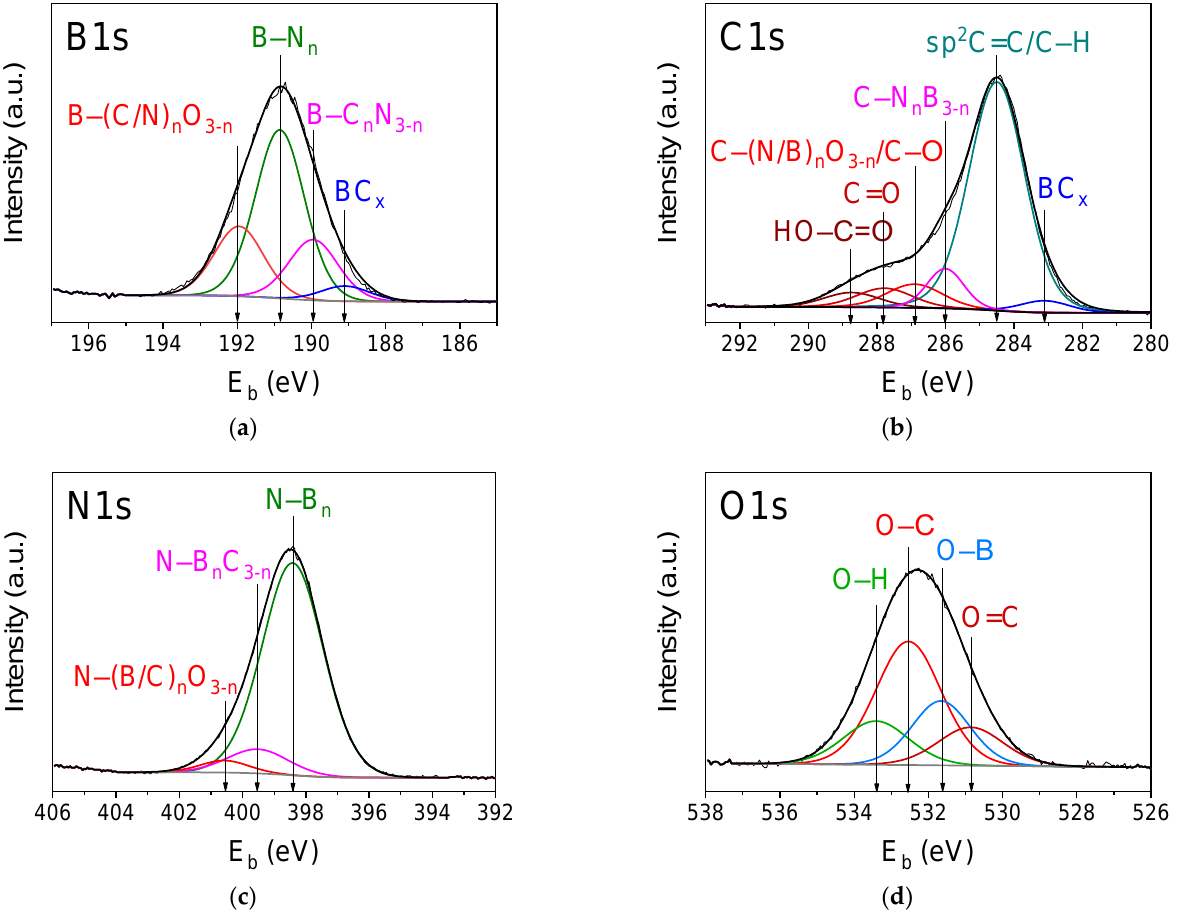
Figure 9. XPS spectra of ( a ) B 1s, ( b ) C 1s, ( c ) N 1s, and ( d ) O 1s core levels for PECVD B 0.30 C 0.27 N 0.29 O 0.14 film deposited at 523